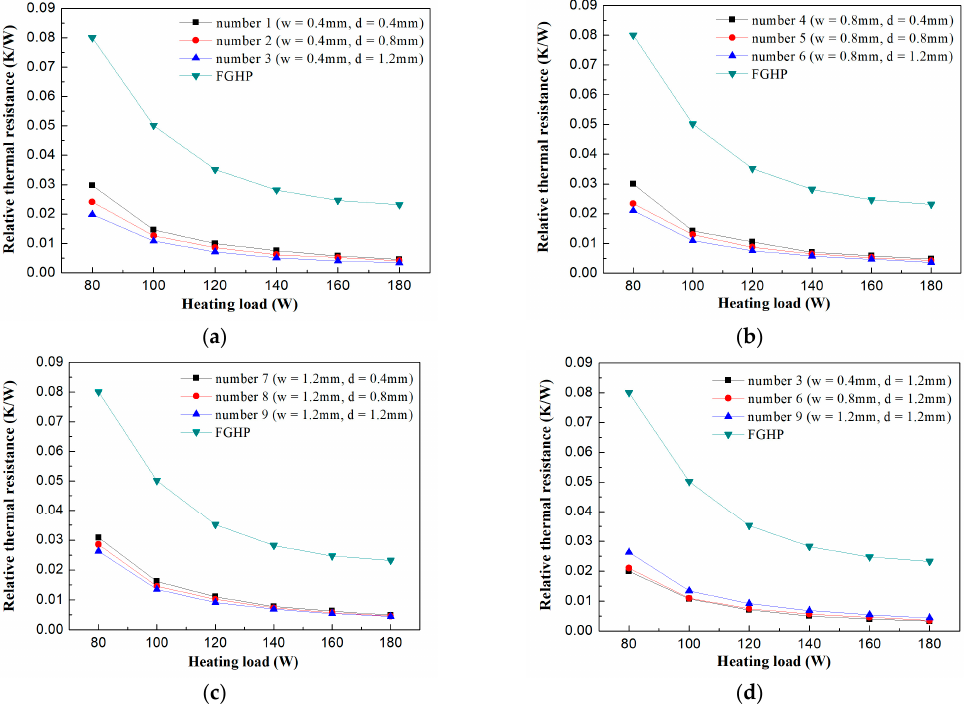
Figure 5. The relative thermal resistance of the FMGHPs and FGHP at different heating loads: ( a ) FMGHPs 1–3 and FGHP; ( b ) FMGHPs 4–6 and FGHP; ( c ) FMGHPs 7–9 and FGHP; ( d ) FMGHPs 3, 6, 9 and FGHP.